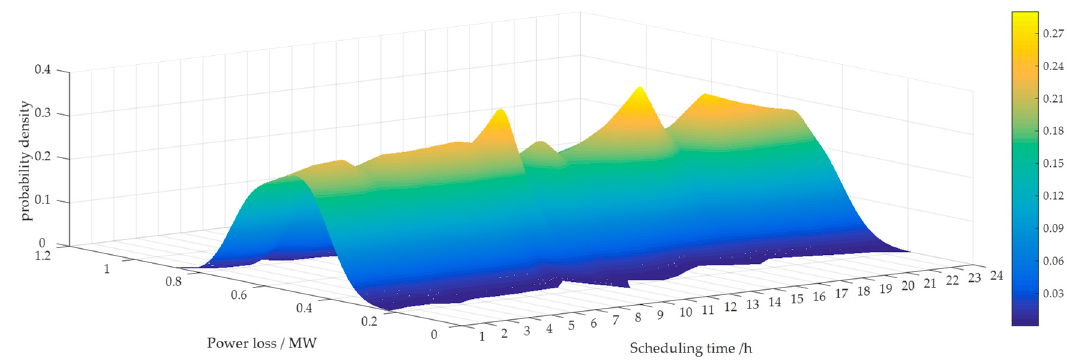
Figure 12. Probability density curve of power loss in a day.